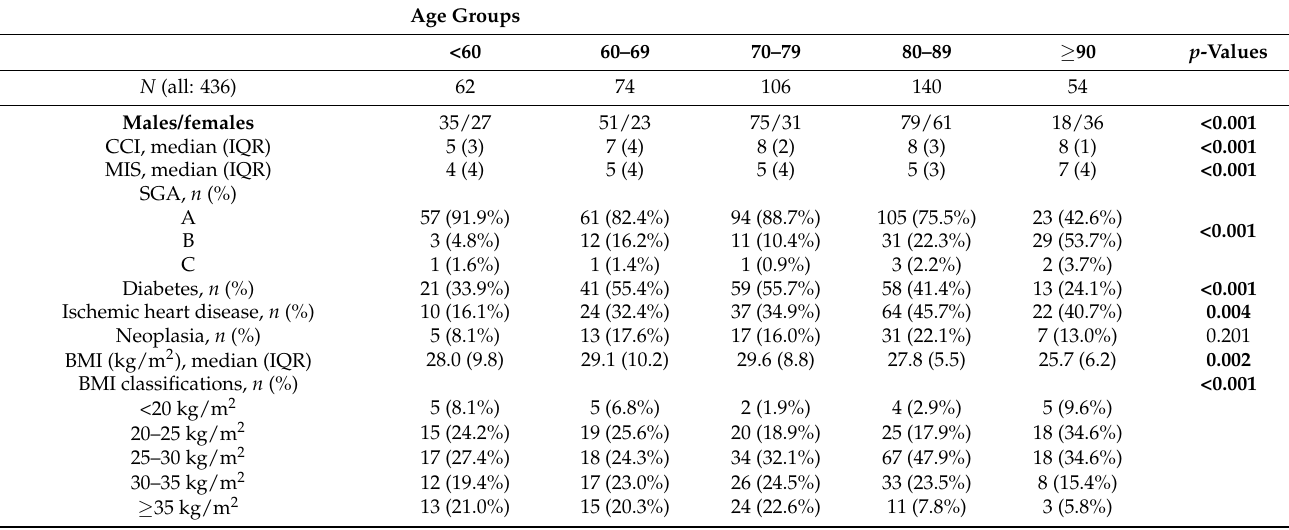
Table 2. Comorbidities, Malnutrition-Inflammation Score and Subjective Global Assessment Score in different age groups of CKD stage 3–5